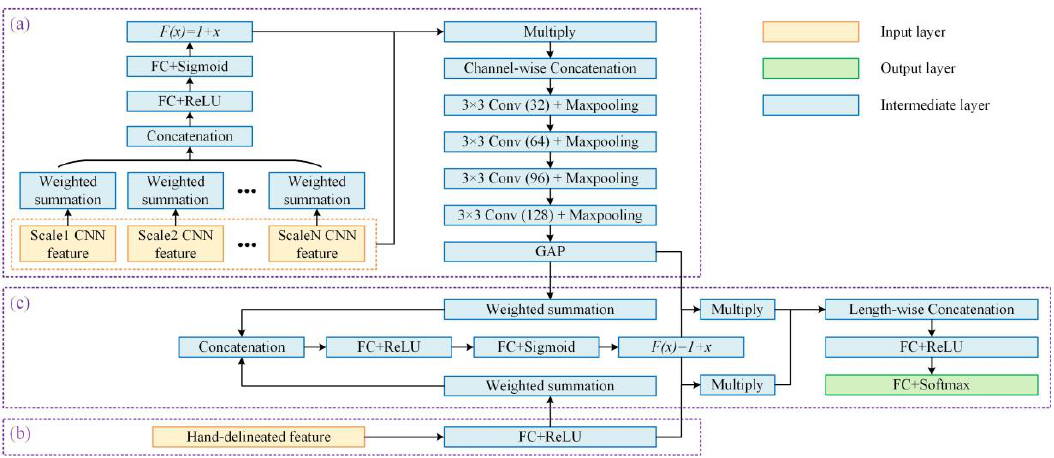
Figure 4. 1-D CNN-MLP hybrid network with attention-based weighting design for comprehensive land-cover classification. ( a ) Multi-scale CNN feature fusion and encoding. ( b ) Hand-delineated feature encoding. ( c ) Multi-scale and multi-feature fusion and classification. CNN: convolutional neural network; MLP: multi-layer perception.